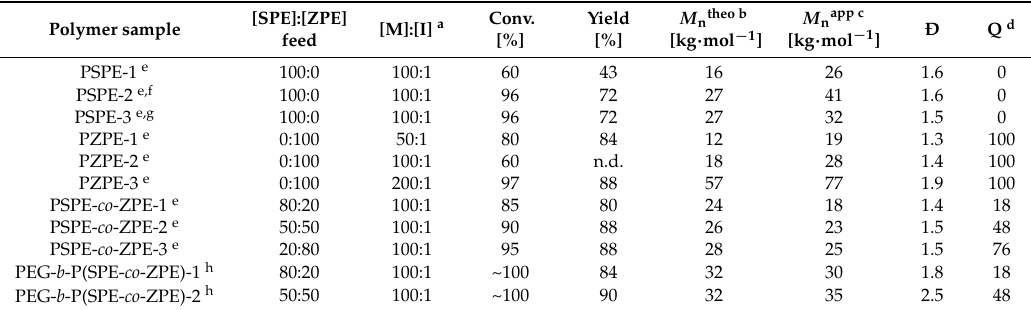
Table 2. Analytical data of statistical copolymers of SPE and ZPE, and of statistical block copolymers mPEG 114 - b -P(SPE- co -ZPE) n obtained by ATRP in solvent TFE using EBiB as low molar mass and mPEG-Br as as macroinitiator, respectively, and CuBr/2,2-bipyridyl as catalyst system at 60 ◦ C/24 h, and reagents